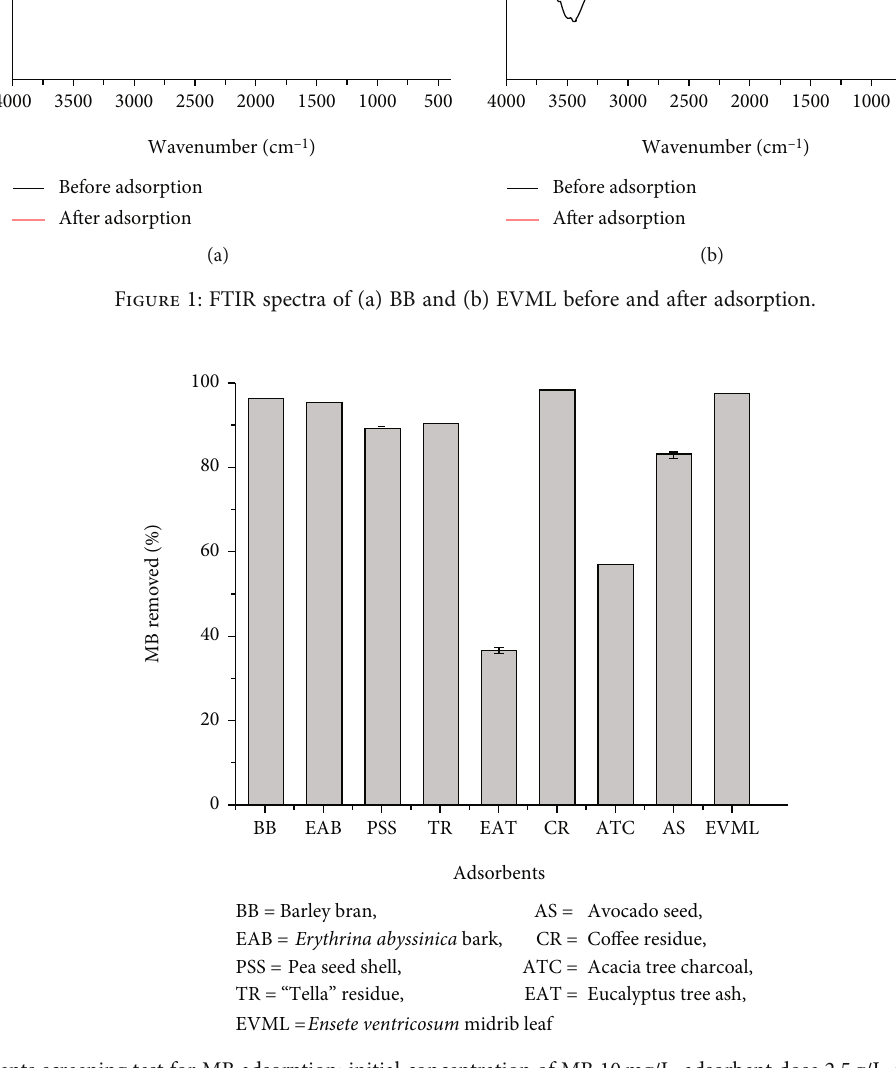
Figure 2: Adsorbents screening test for MB adsorption: initial concentration of MB 10 mg/L, adsorbent dose 2.5g/L, pH 5.7, agitation time 24h, shaking speed 200rpm, and temperature 25 ± 1 ° C